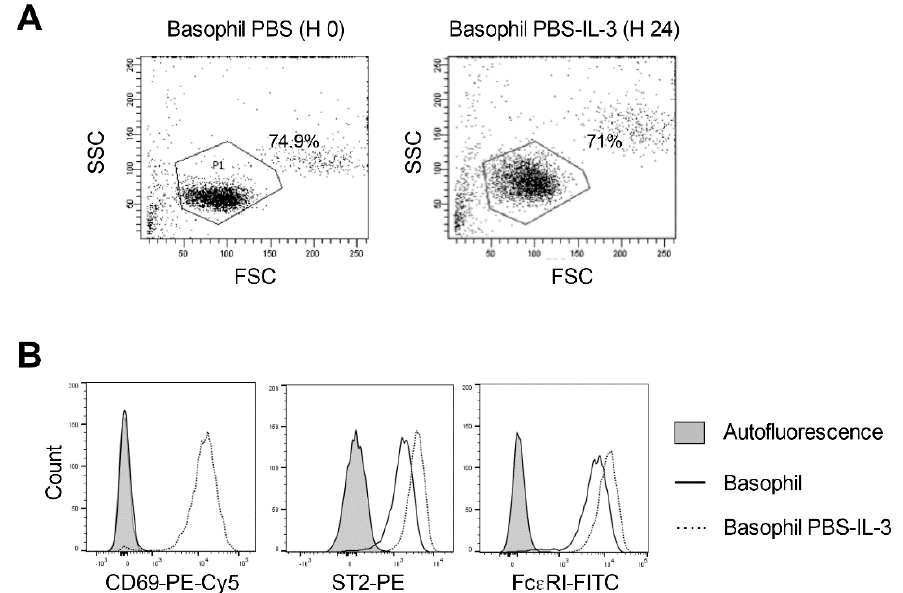
Figure 3. Response of the phosphate buffered saline (PBS)-treated human peripheral blood basophils to IL-3 stimulation. Basophils were incubated on ice for 5 min with PBS. Cells were then washed and cultured in serum-free X-VIVO 15 medium (0.1 × 10 6 cells/well per 200 µL) in 96-well U-bottomed plate along with IL-3 (100 ng/0.5 million cells) for 24 h. ( A ) The forward and side scatter plot of the basophils immediately following PBS treatment and following 24-h culture in the presence of IL-3. ( B ) Histogram overlays showing the expression of basophil activation markers CD69, ST2 and Fc ε RI